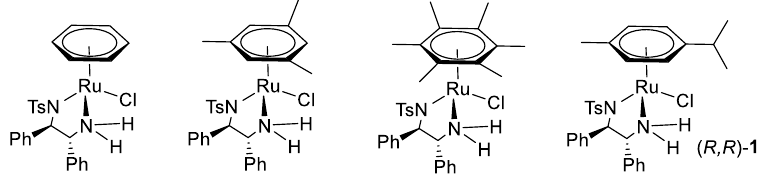
Figure 5. Variation of the η 6 -arene ring in Noyori – Ikariya catalysts.